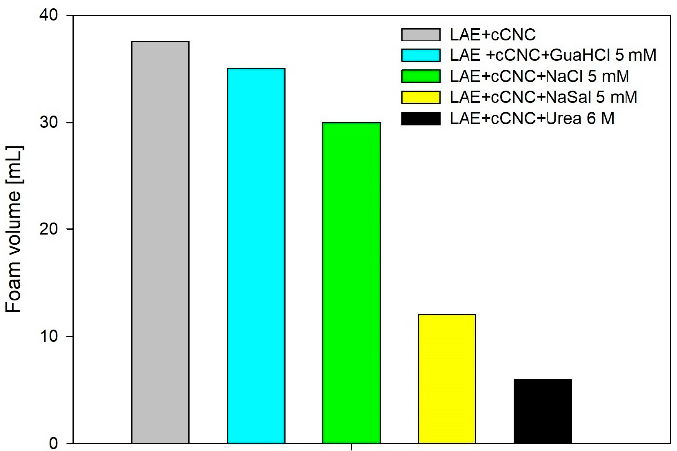
Figure 2. Foam volume of LAE 0.006 wt.% and carboxylated nanocrystals 0.3 wt.% with additional compounds in the dispersion.